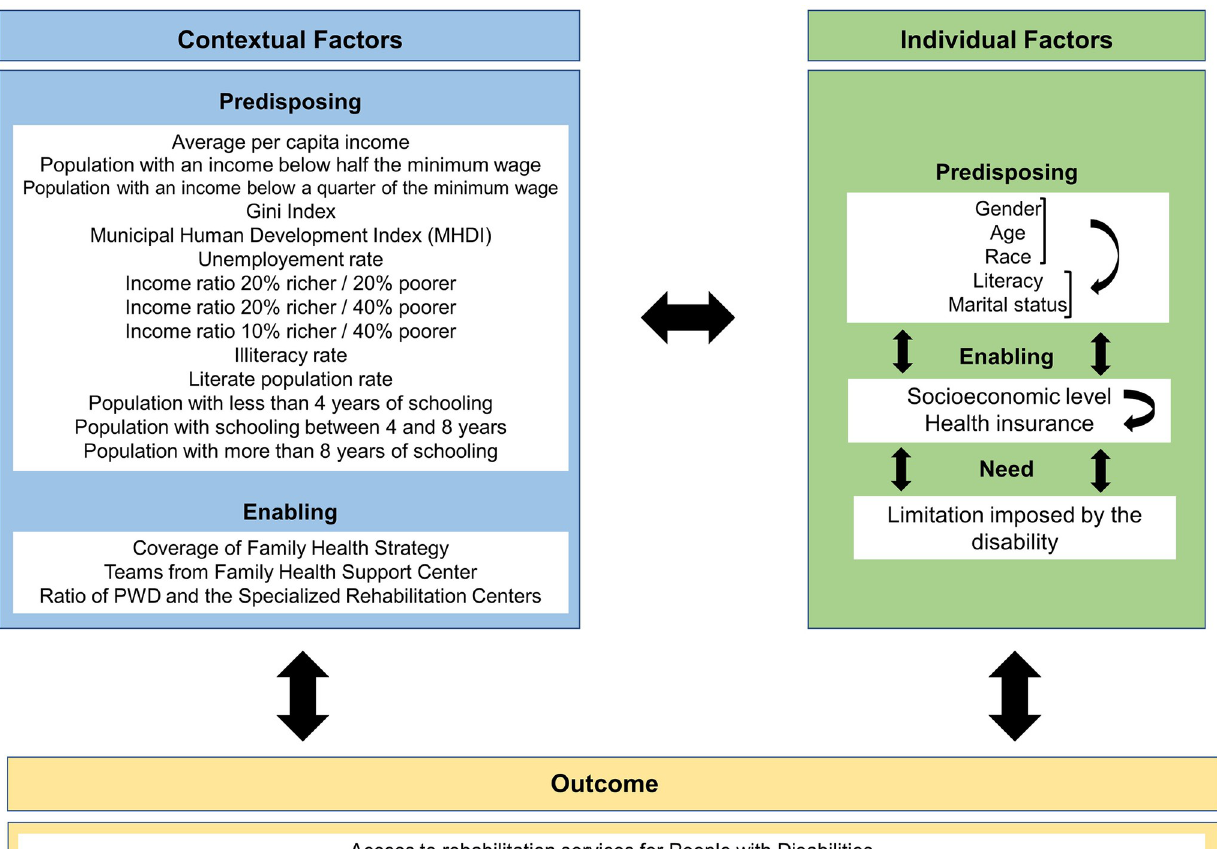
Fig 1. Access concept framework. Source: Adapted from Andersen